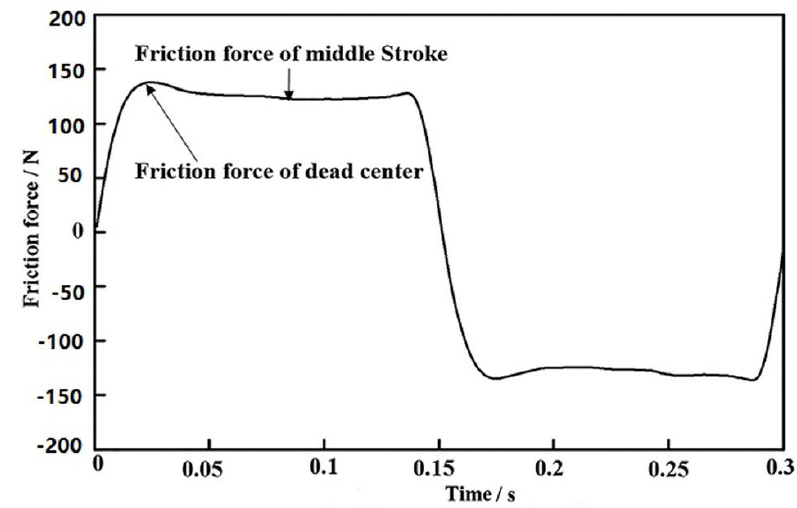
Figure 4. The friction force of a typical reciprocating stroke in the stable wear period.